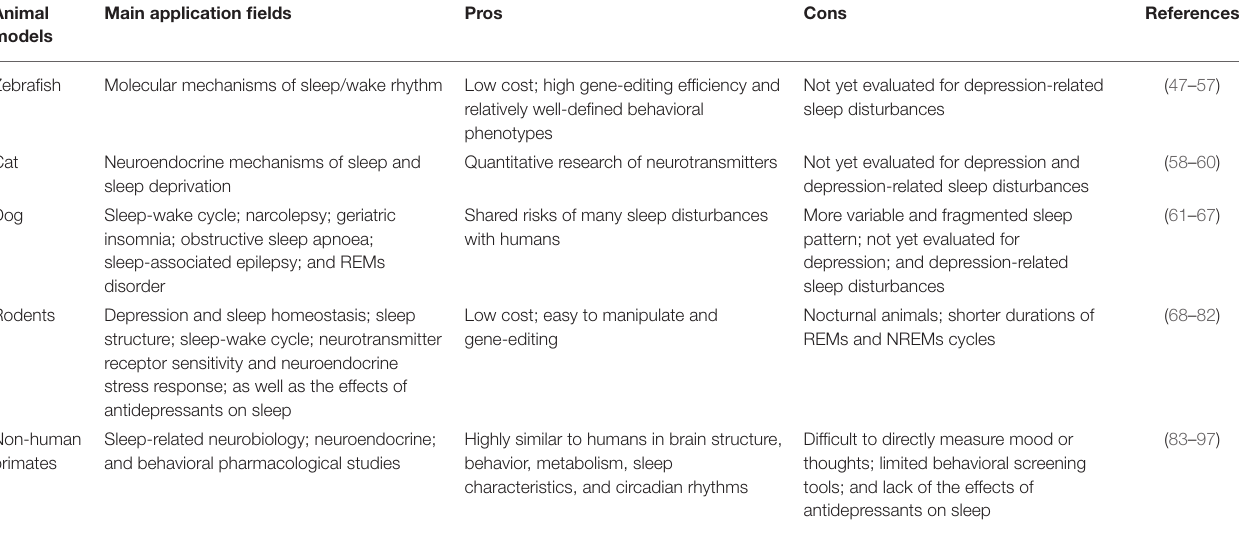
TABLE 1 | Comparison of different animal models used to study sleep disturbances and depression. Animal